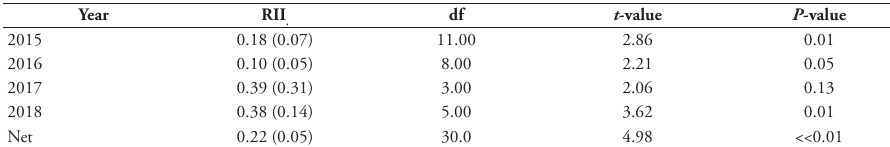
Table 1. Mean effects (RII ± SE) of shrubs on annual species at the community level. RII values are sum- marised across all annual species for each year of the study (2015–2018) and for all study years combined (Net). P ≤ 0.05 indicates that RII values differ significantly from zero, according to independent t- tests. RII df .